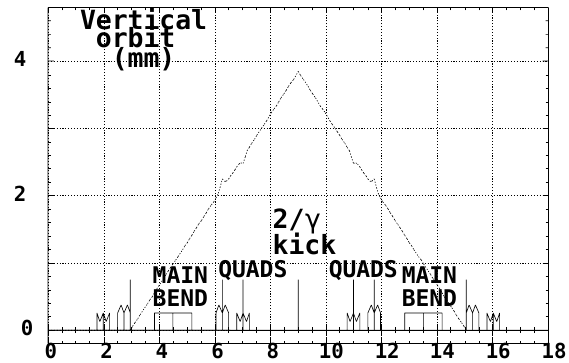
FIG. 9. Vertical triangular orbit bump straddling a typical syn- chrotron cell.